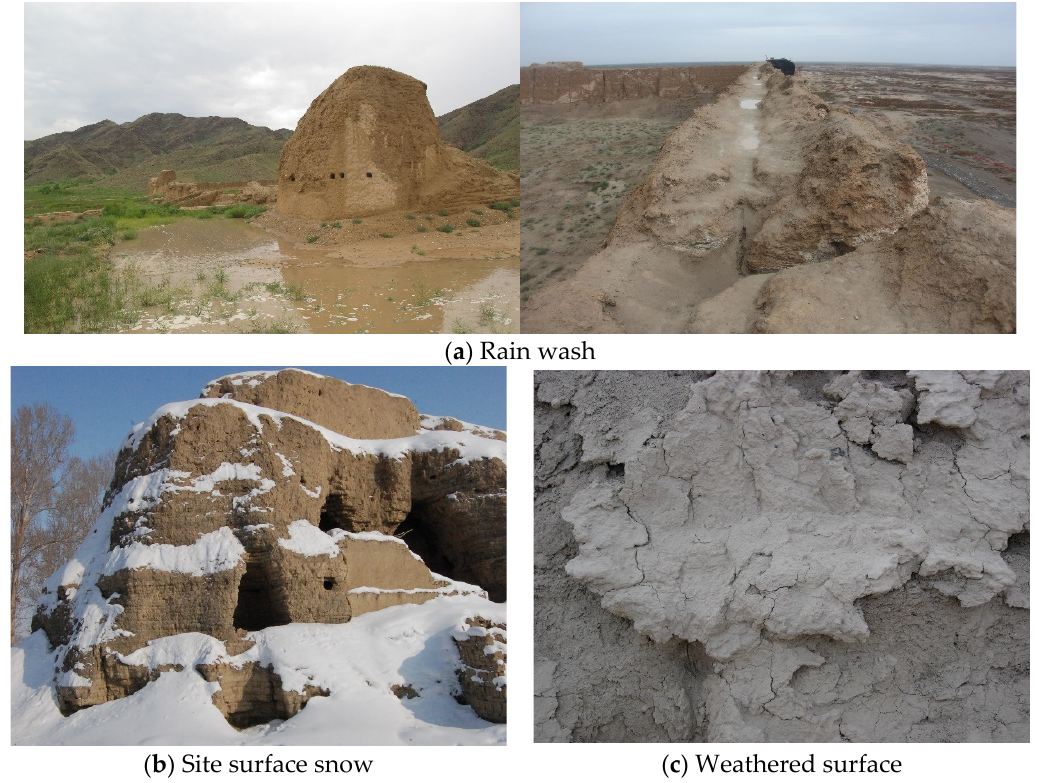
Figure 1. Influence of natural conditions.